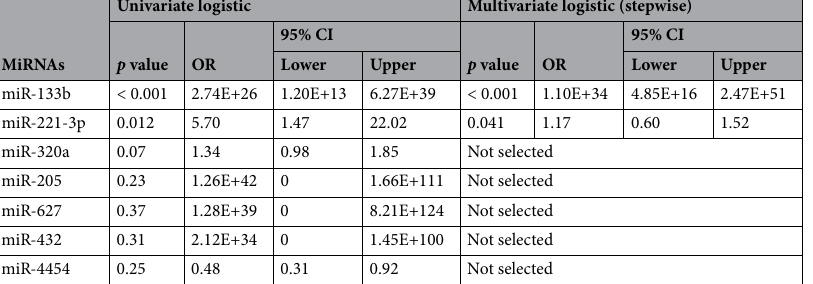
Univariate logistic Multivariate logistic MiRNAs